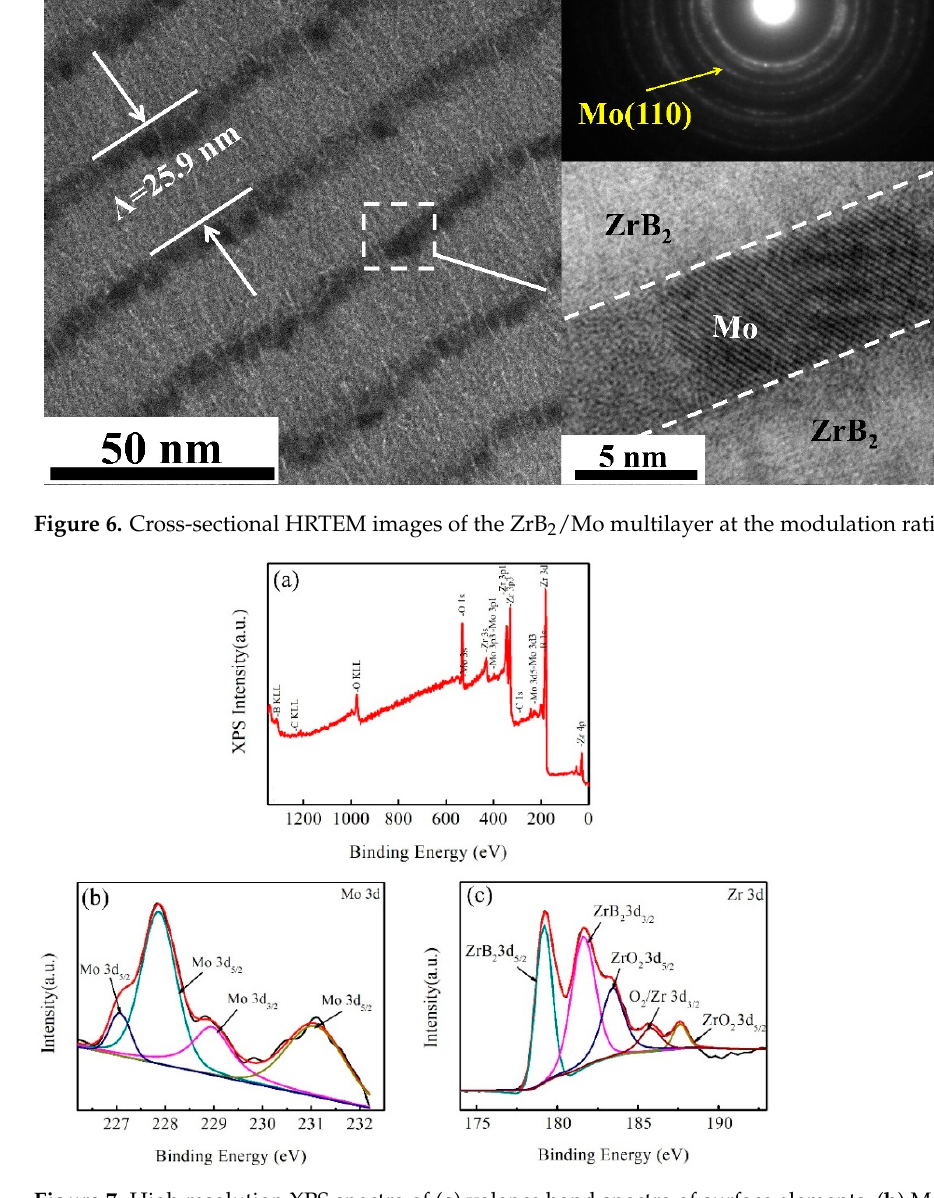
Figure 7. High resolution XPS spectra of ( a ) valence band spectra of surface elements, ( b ) Mo3 d, and ( c ) Zr3 d of the ZrB 2 /Mo multilayers with modulation ratio of t ZrB2 :t Mo = 1:1.